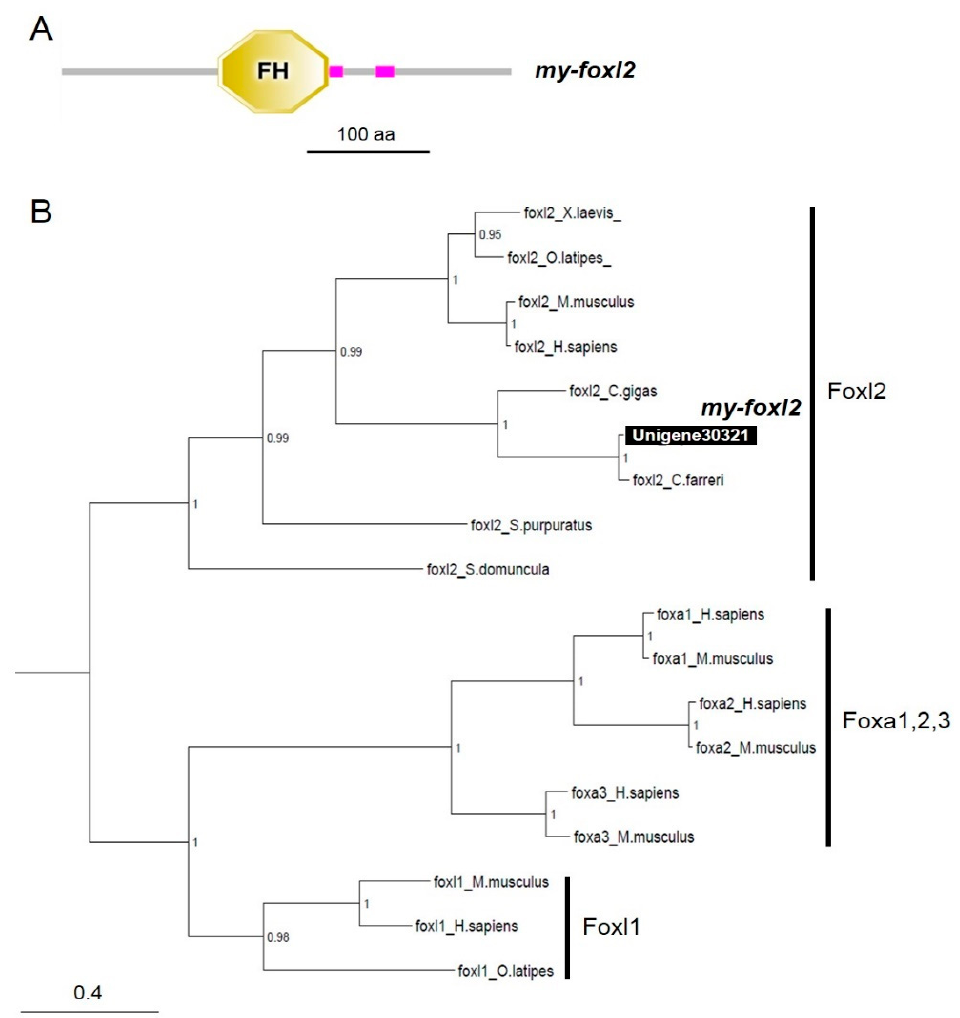
Figure 4. Domain analysis and phylogenic tree of my-foxl2 . ( A ) Domain structure analysis of my-foxl2 by SMART. The forkhead (FH) domain is indicated. The scale bar represents a length of 100 amino acids. ( B ) The numbers at the nodes indicate Bayesian posterior probability. The scale bar indicates amino acid substitutions per site. GenBank accession numbers for the sequences are listed in Table S2.